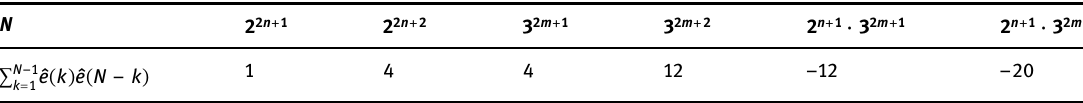
Table 1: Values of